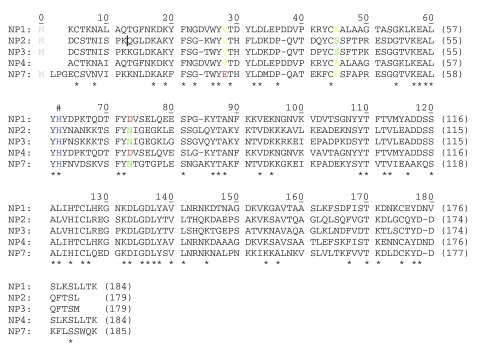
Amino acid sequence alignment of
R. prolixus NP1 (Swiss-Port entry Q26239), NP2 (Swiss-Port entry Q26241), NP3 (Swiss-Port entry Q94733), NP4 (Swiss-Port entry Q94734), and NP7 (Swiss-Prot entry Q6PQK2)
(1).The total sequence identity among all five protein sequences amount to 33% (indicated by ‘*’). The proximal His is indicated by ‘#’. An initial Met residue (in grey) results in case of the recombinantly expressed proteins of NP1, NP2, NP3, and NP7 is not present in the mature proteins
in vivo (
2, 3). Residues of relevance to this study are highlighted in color.